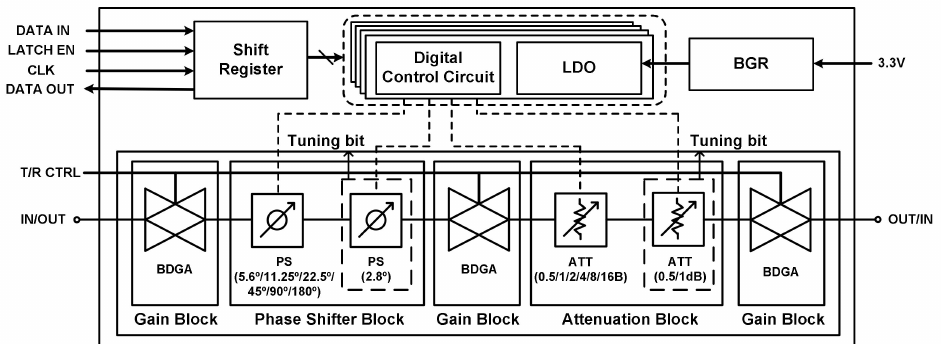
Figure 1. Block diagram of the Ku-band CMOS transmit and receive IC.